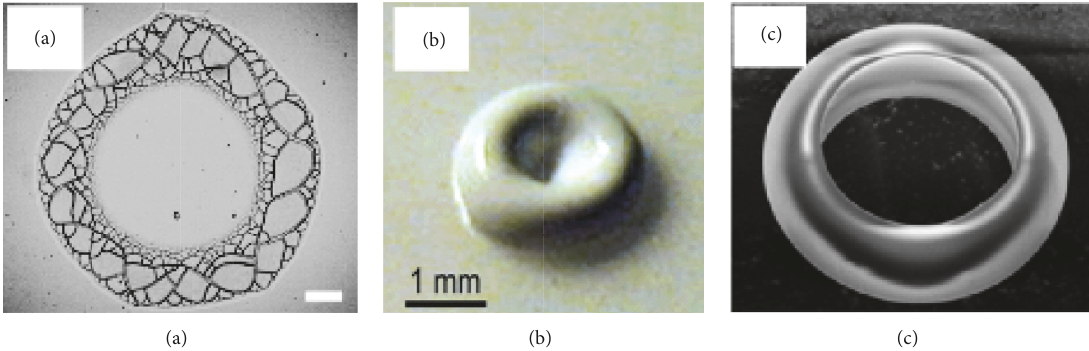
Figure 10: Different drying patterns obtained from varied conditions. (a) Coffee ring-like stain on hydrophilic substrate, reprinted with permission from [37]; (b) bowl-shaped relic on hydrophobic surface, reprinted with permission from [67]; (c) ring-shaped residue obtained from acoustic levitation, reprinted with permission from